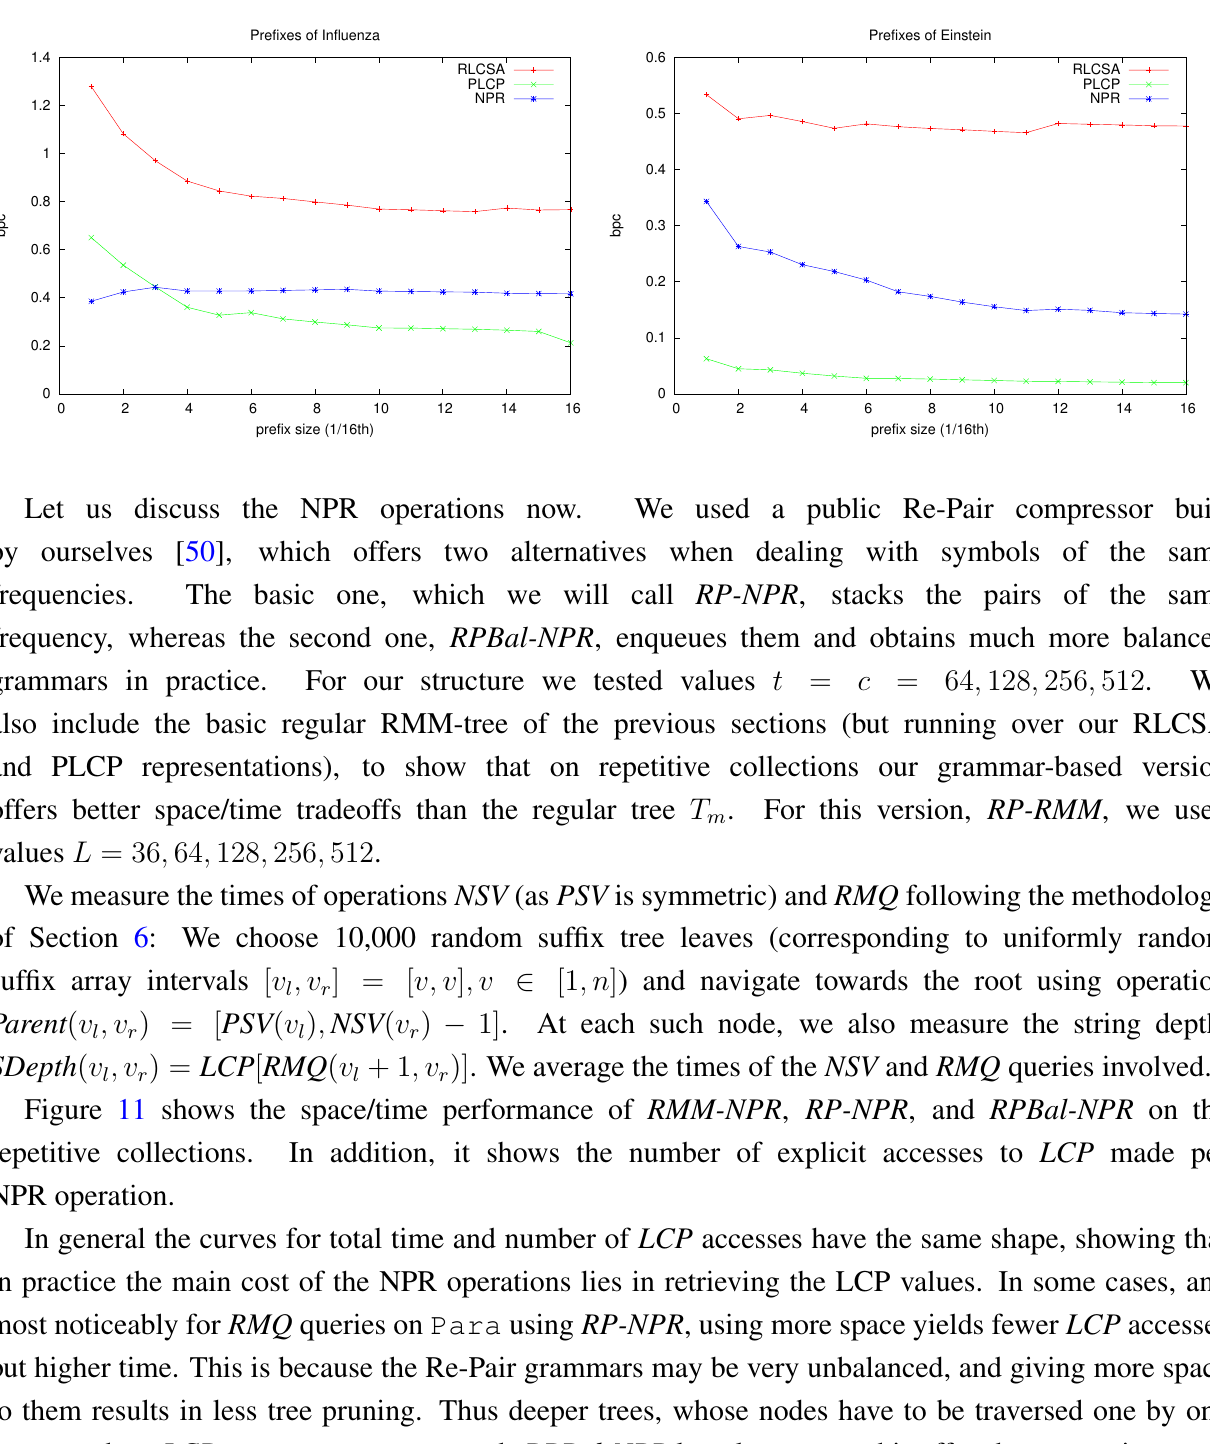
Figure 10. Evolution of the space, in bpc, of our structures for increasing prefixes of collections Influenza and Einstein